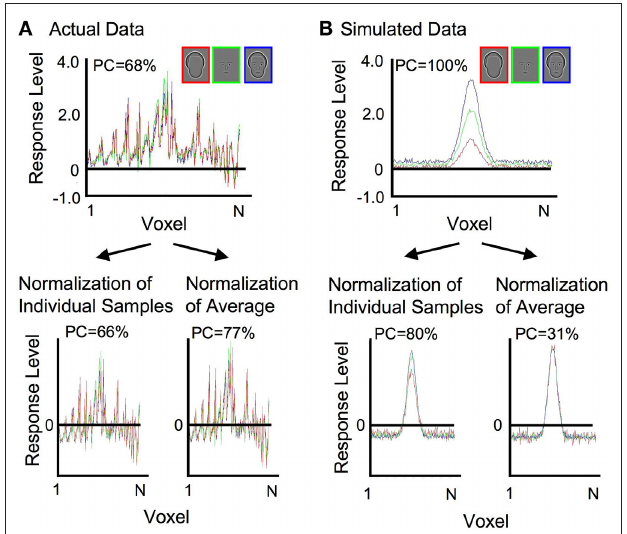
Figure 3 | Demonstration of the effects of alternative normalization procedures on actual and simulated data. (A) Actual data from an individual subject is shown before normalization and following each of two different normalization procedures. Classification performance (PC = percent correct) remained high for both types of normalization. (B) The simulated data incorporated additive and multiplicative scaling of a single Gaussian spatial pattern of activation. Classification performance was preserved when normalization was conducted on each individual sample. Classification fell to chance levels when normalization was conducted on the mean response pattern of each